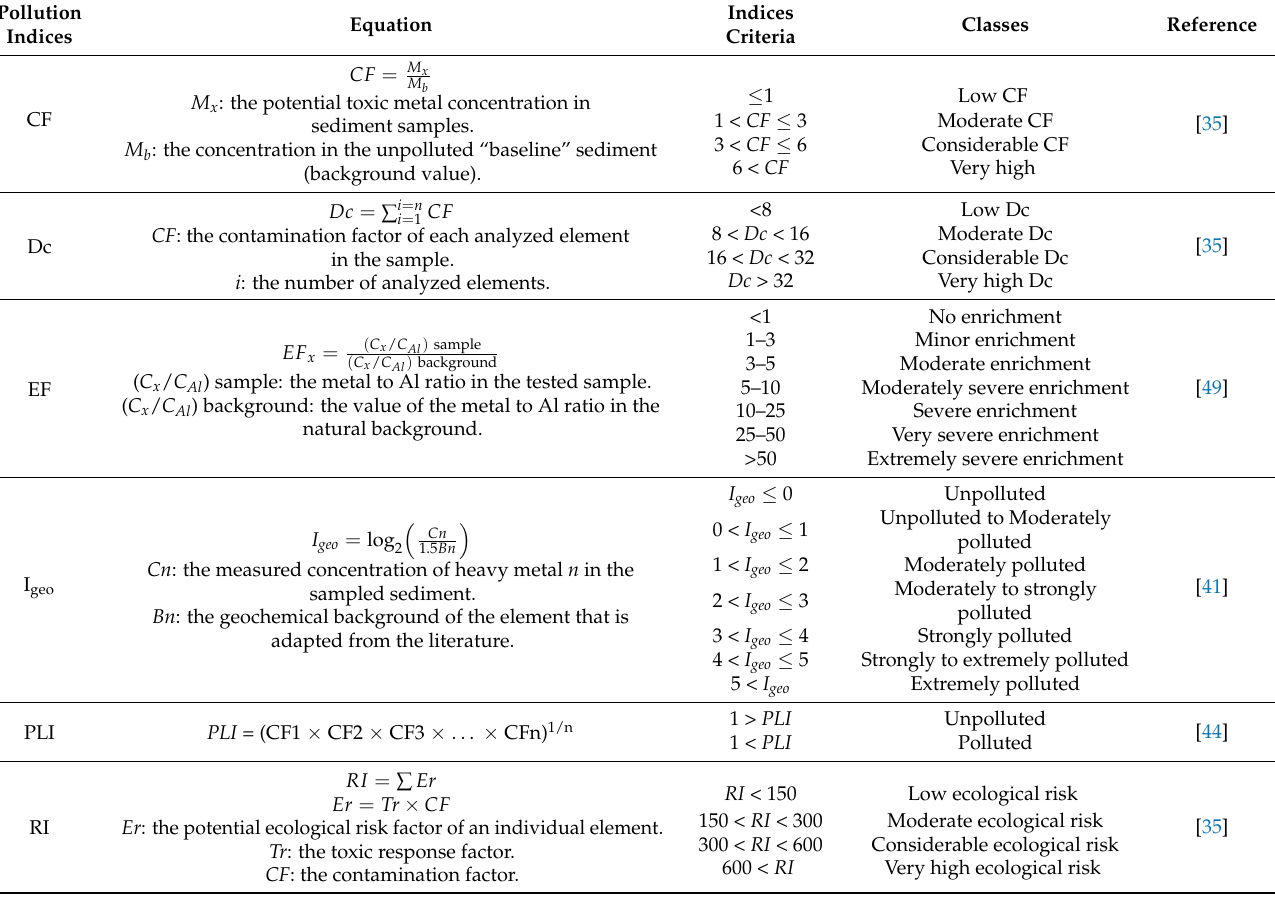
Table 1. The pollution indices equations and their classifications: potential ecological risk index (RI), degree of contamination (Dc), pollution load index (PLI), contamination factor (CF), enrichment factor (EF), and geoaccumulation index (I geo